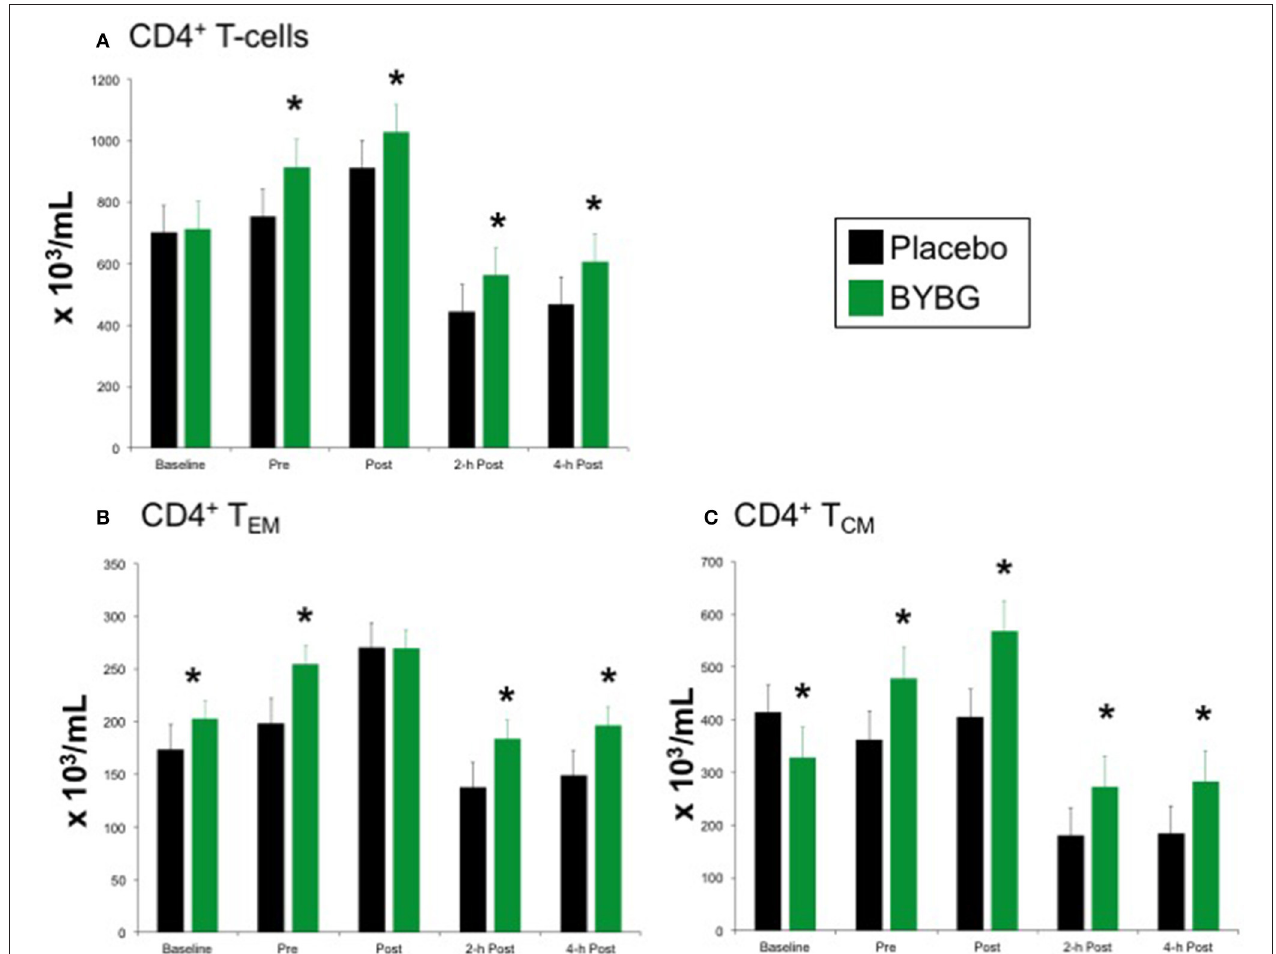
FIGURE 5 | Effect of BYBG on CD4 + T cells. CD4 + T cell concentrations were determined using peripheral blood mononuclear cells (PBMC) isolated from human whole blood samples. PBMCs were analyzed using flow cytometry to determine total ( A , CD3 + /CD4 + ), T EM ( B , CCR7-/CD45RA-), and T CM ( C , CCR7 + /CD45RA-) concentrations. Placebo (black bars) and BYBG (green bars) are represented separately and were statistically compared. Values represent the mean ± SEM. *indicates BYBG significantly different than placebo ( p <